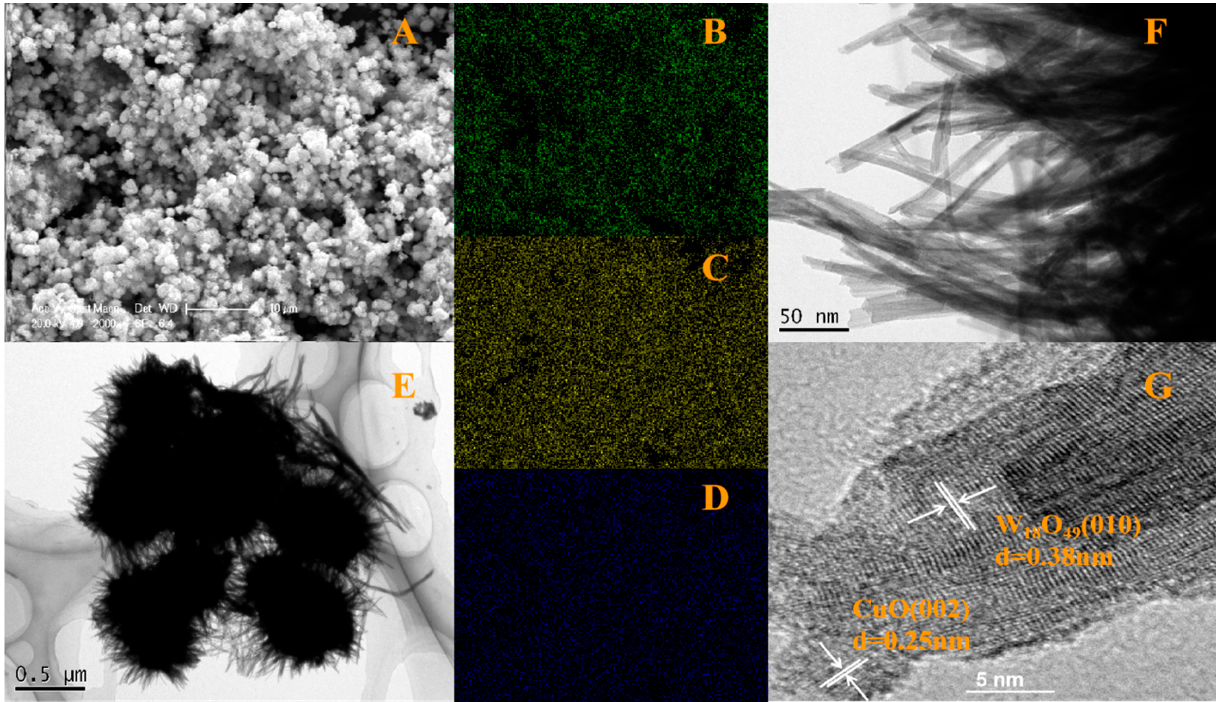
Figure 2. ( A ) SEM images of CuO/W 18 O 49 microspheres, and ( B – D ) corresponding elemental mapping images of the elements W, O and Cu in the doped samples. ( E ) TEM image of CuO/W 18 O 49 microspheres; ( F ) a magnified TEM image of CuO/W 18 O 49 microspheres; ( G ) a HRTEM image of CuO/W 18 O 49 microspheres.